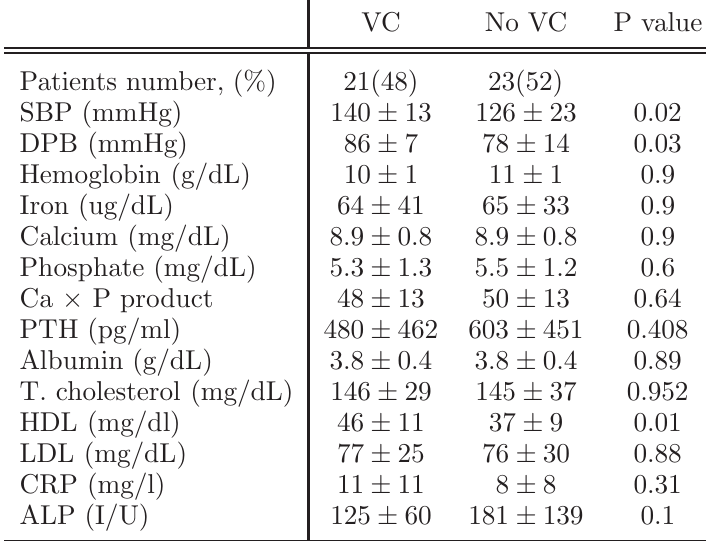
Table 2 Hemodynamic and biochemical parameters for the groups with and without cardiac valve calcification.